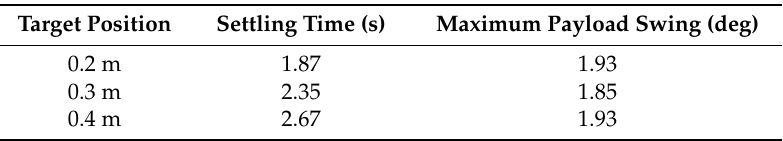
Table 5. Performance within angle